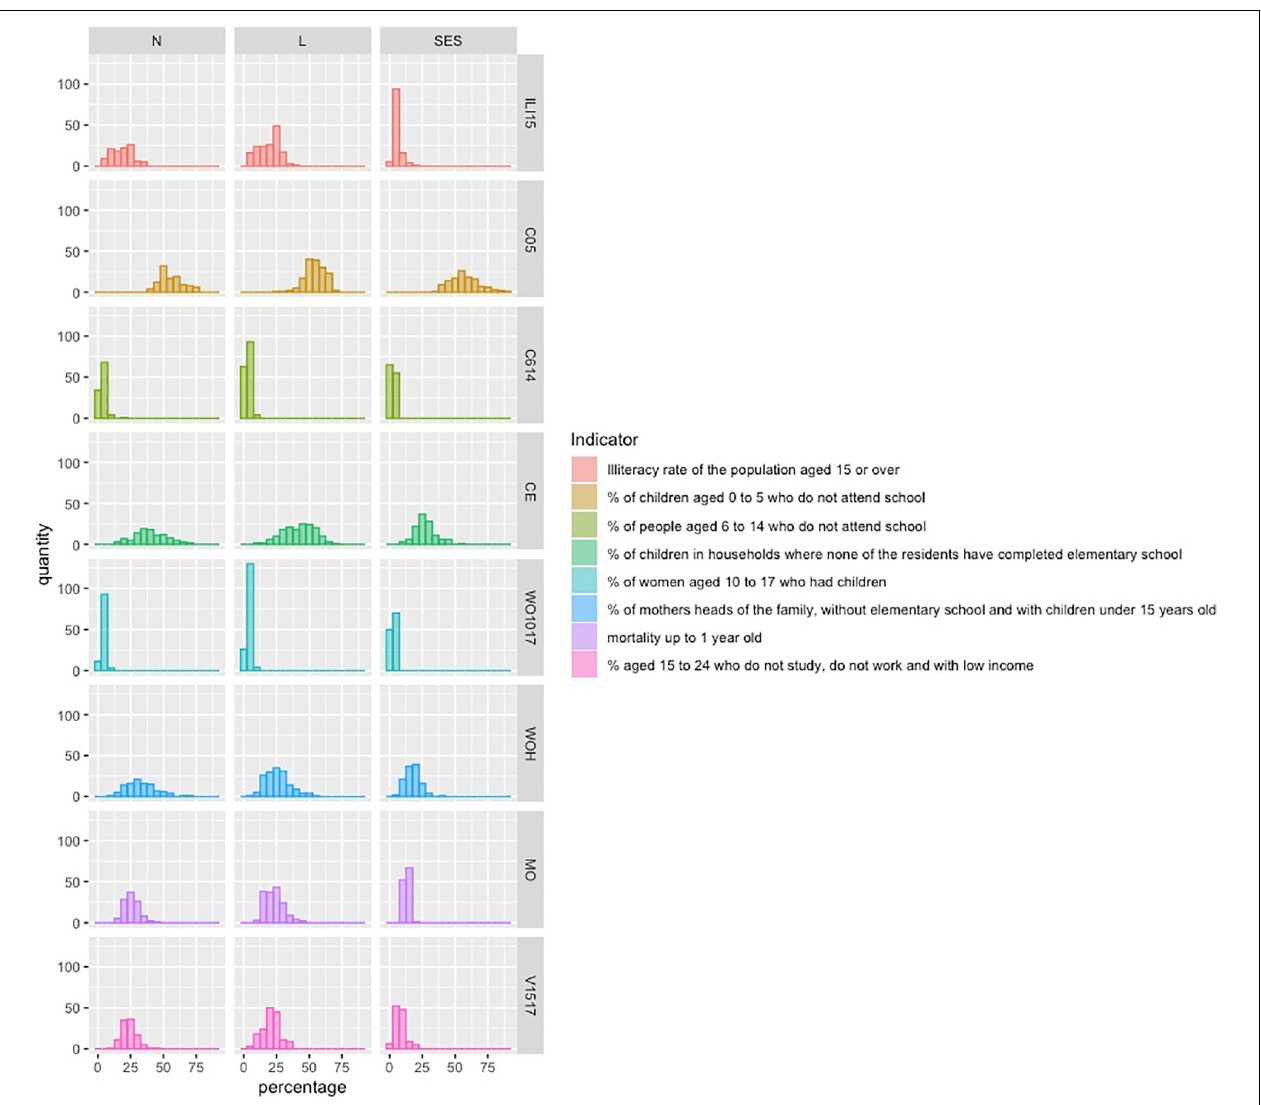
FIGURE 14 | Histogram of the municipal distribution based on the SVI Human Capital dimension indicators. Elaborated by the authors with data from IPEA